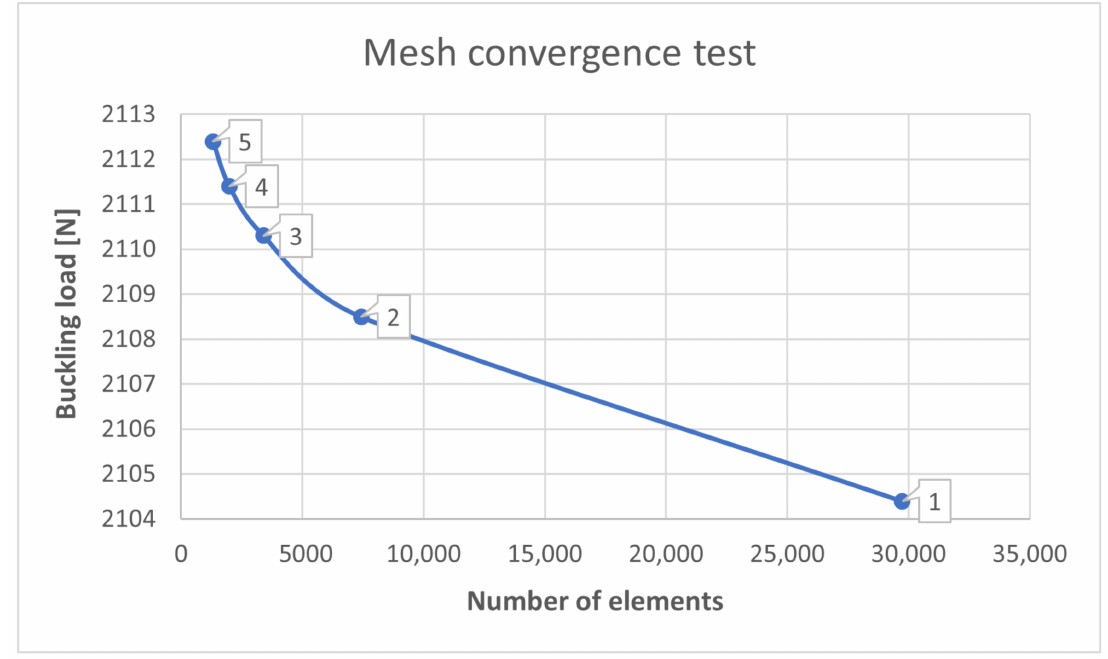
Figure 4. The convergence test